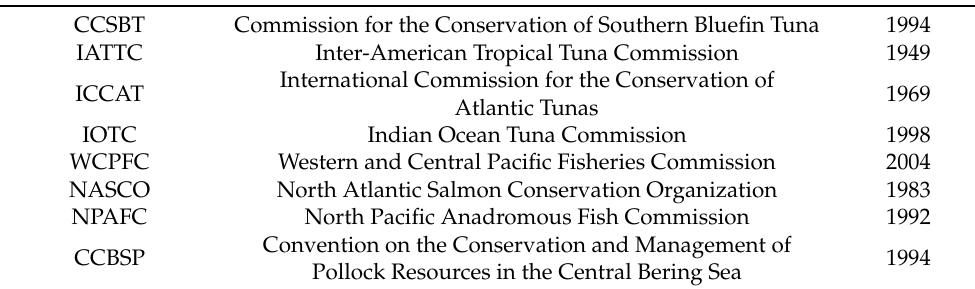
Table 3. Specialized